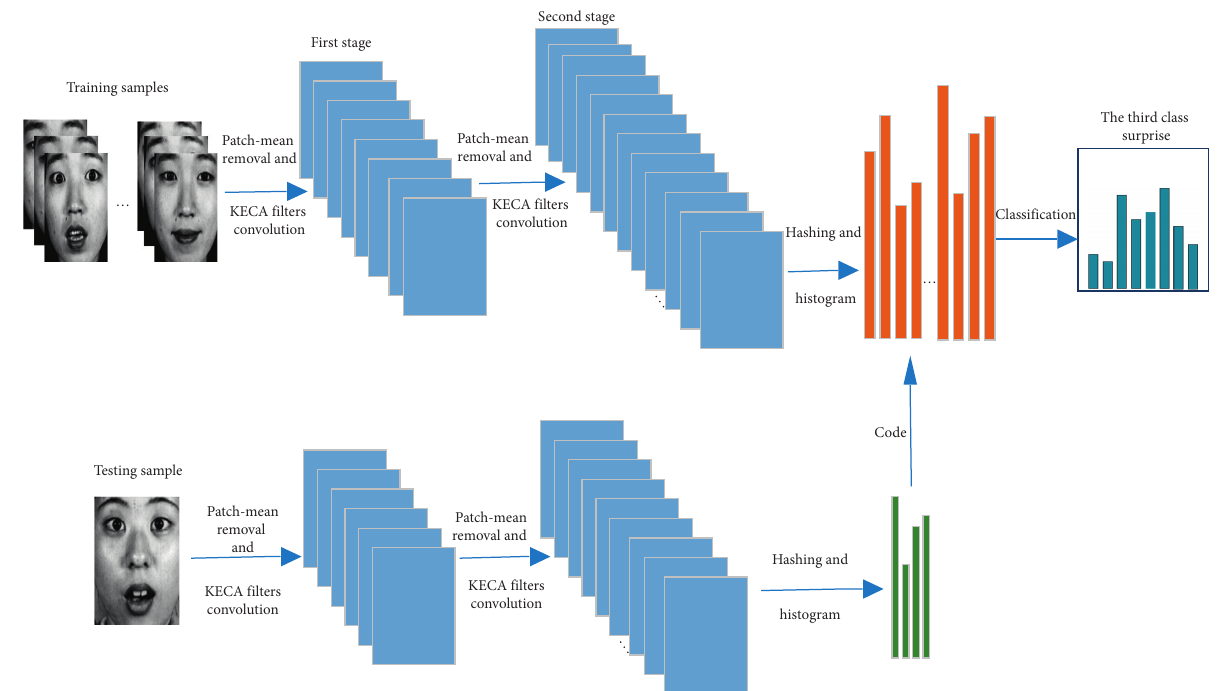
Figure 3: An illustration of the KECANet